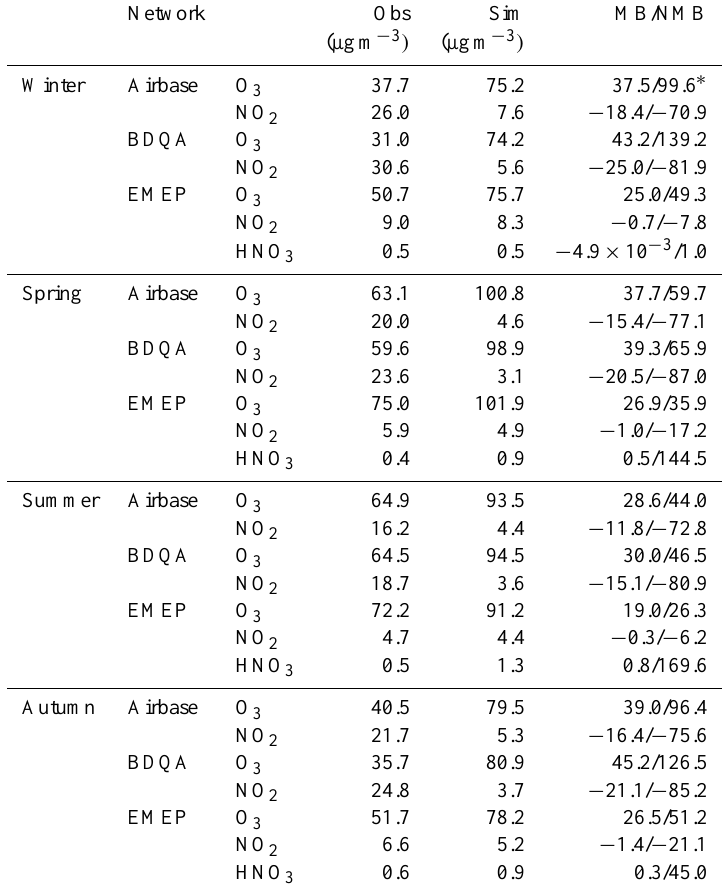
Table 4. The observed values and the mean bias (MB) and normalized mean bias (NMB, in %) of the prediction of O 3 NO 2 , and HNO 3 mixing ratios over Europe in